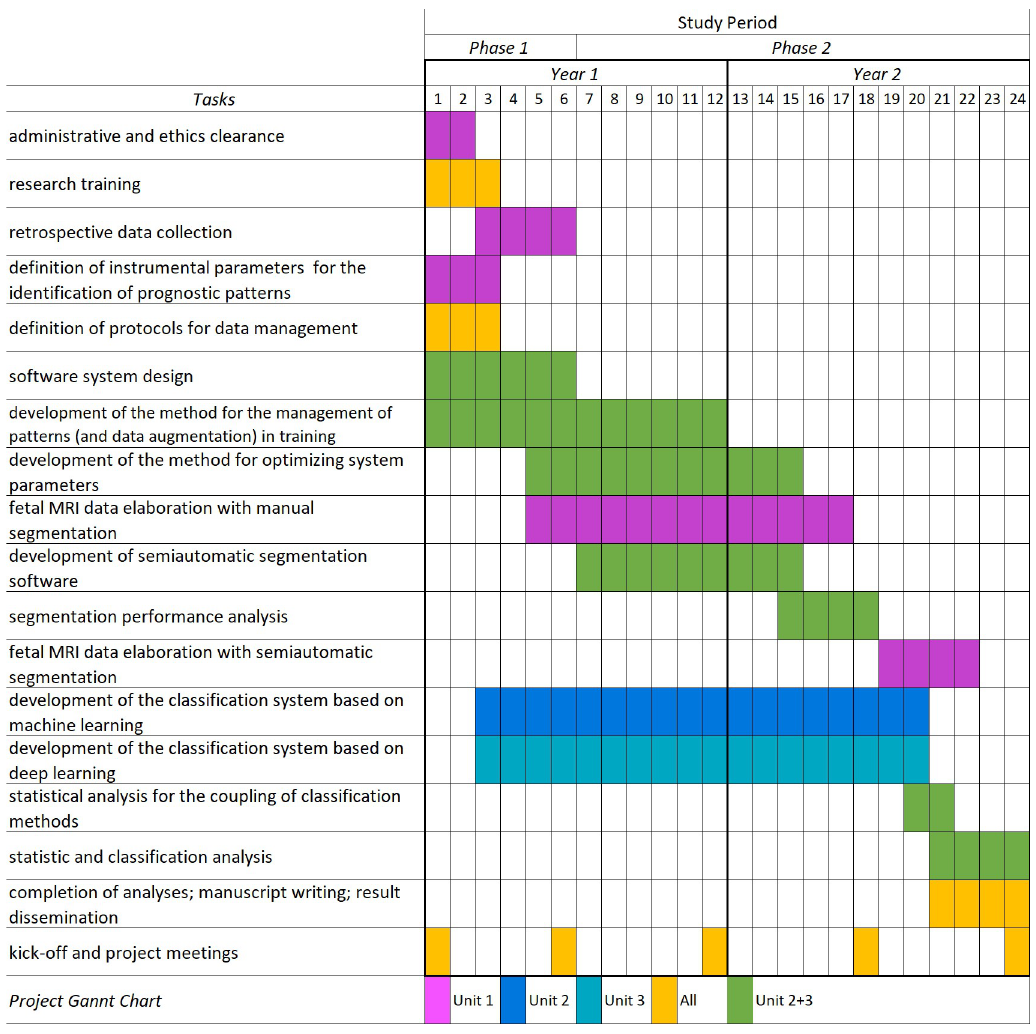
Fig 1. Standard protocol items. Standardized Protocol ItemsRecommendations for Observational Retrospective Study (SPIROS) flow diagram: Schedule for administrative and ethics clearance; research training; retrospective data collection; definition of instrumental parameters for the identification of prognostic patterns; definition of protocols for data management; software system design development of the method for the management of patterns (and data augmentation) in training; development of the method for optimizing system parameters; fetal MRI data elaboration with manual segmentation; development of semiautomatic segmentation software; segmentation performance analysis; fetal MRI data elaboration with semiautomatic segmentation; development of the classification system based on machine learning; development of the classification system based on deep learning; statistical analysis for the coupling of classification methods; statistic and classification analysis; completion of analyses; manuscript writing; result dissemination; kick-off and project meetings. Unit 1: Milan; Unit 2: Lecce; Unit 3: